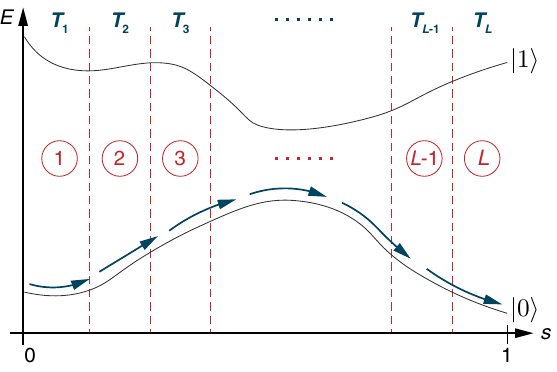
FIG. 5. An illustration of a VQAA by splitting the adiabatic path into L chunks. The ground-state and higher excited-state energies of H ( s ) are shown here, being separated by a finite spec- tral gap. In an adiabatic algorithm, the ground state is prepared by following a path from a trivial Hamiltonian ground state at s = 0 to the target Hamiltonian at s =